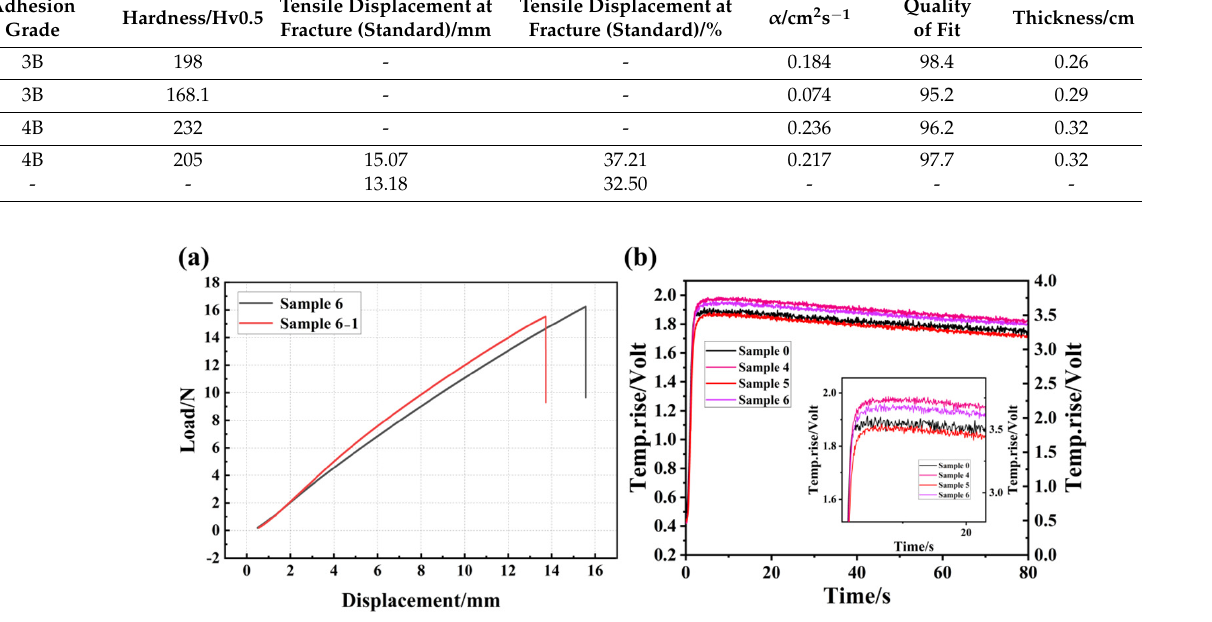
Figure 5. Tensile test results of samples 6 and 6-1 ( a ), and thermal diffusion results of samples 4, 5 and 6 ( b ).